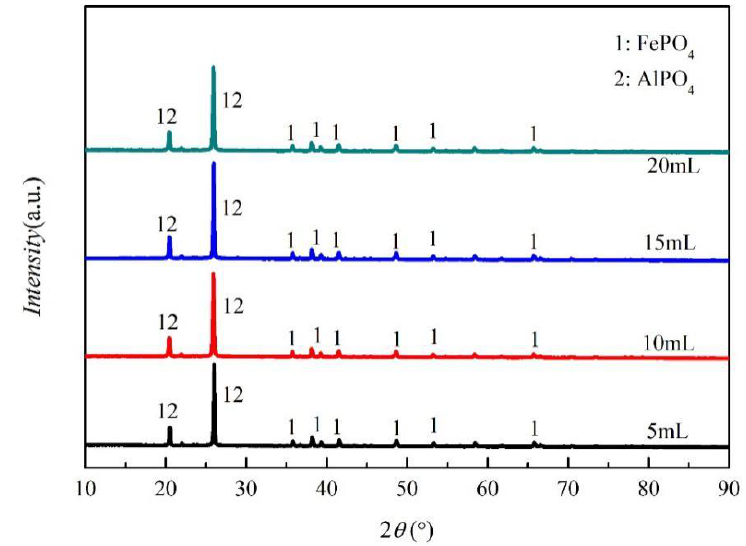
Figure 11. XRD patterns of the samples at di ff erent dosages of polyethylene glycol.